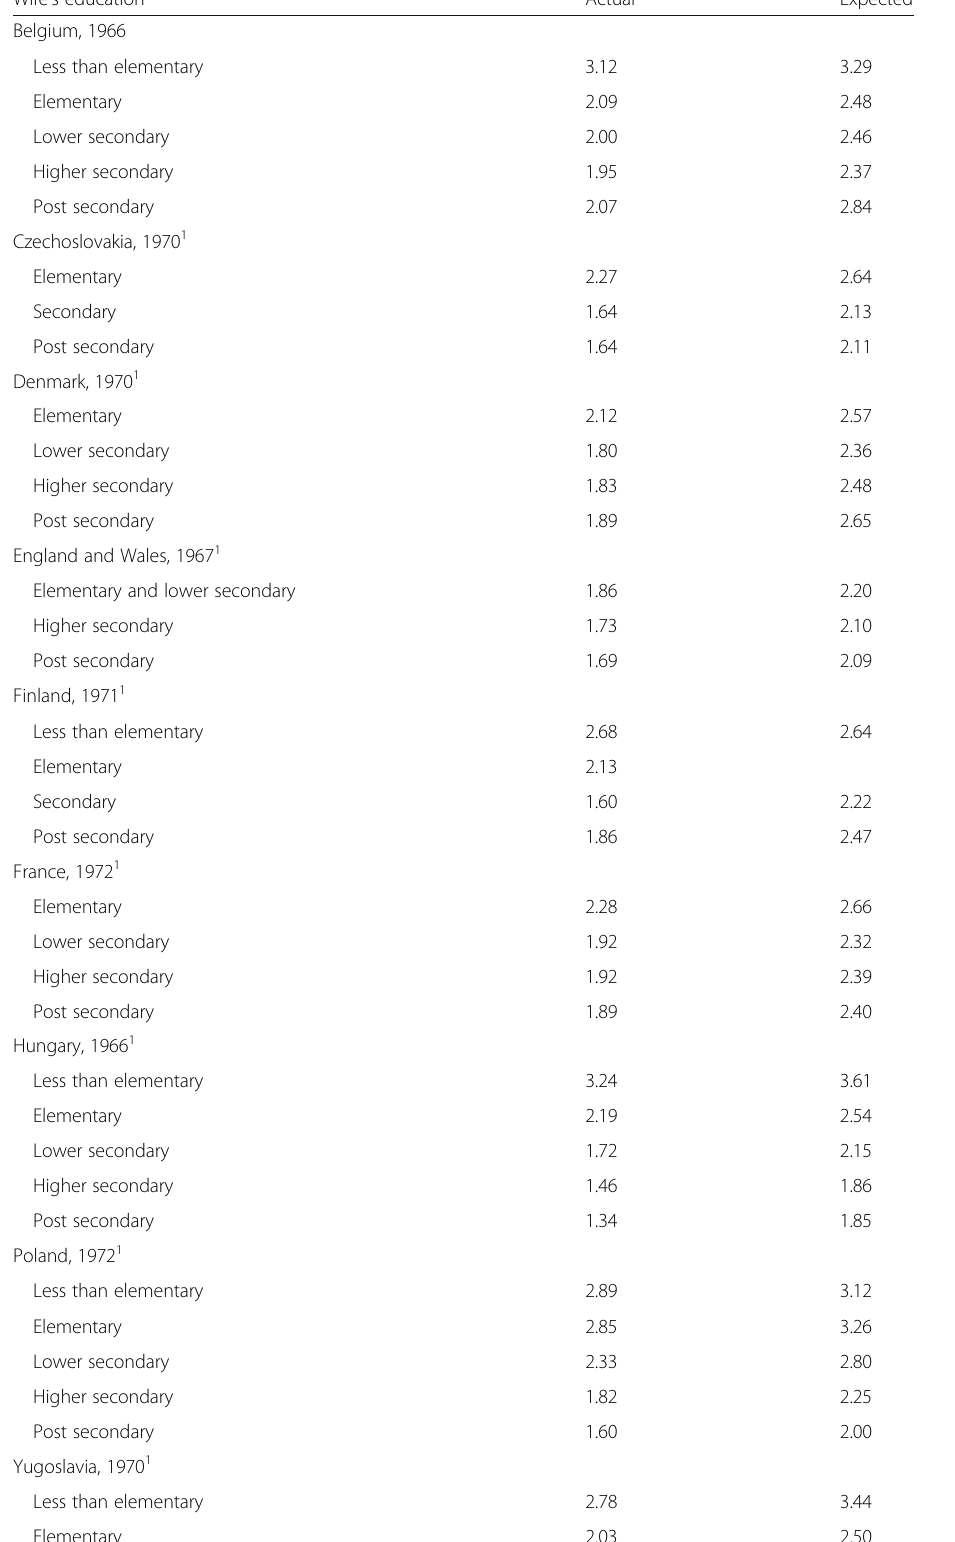
Table 9 Actual and expected number of children according to wife ’ s